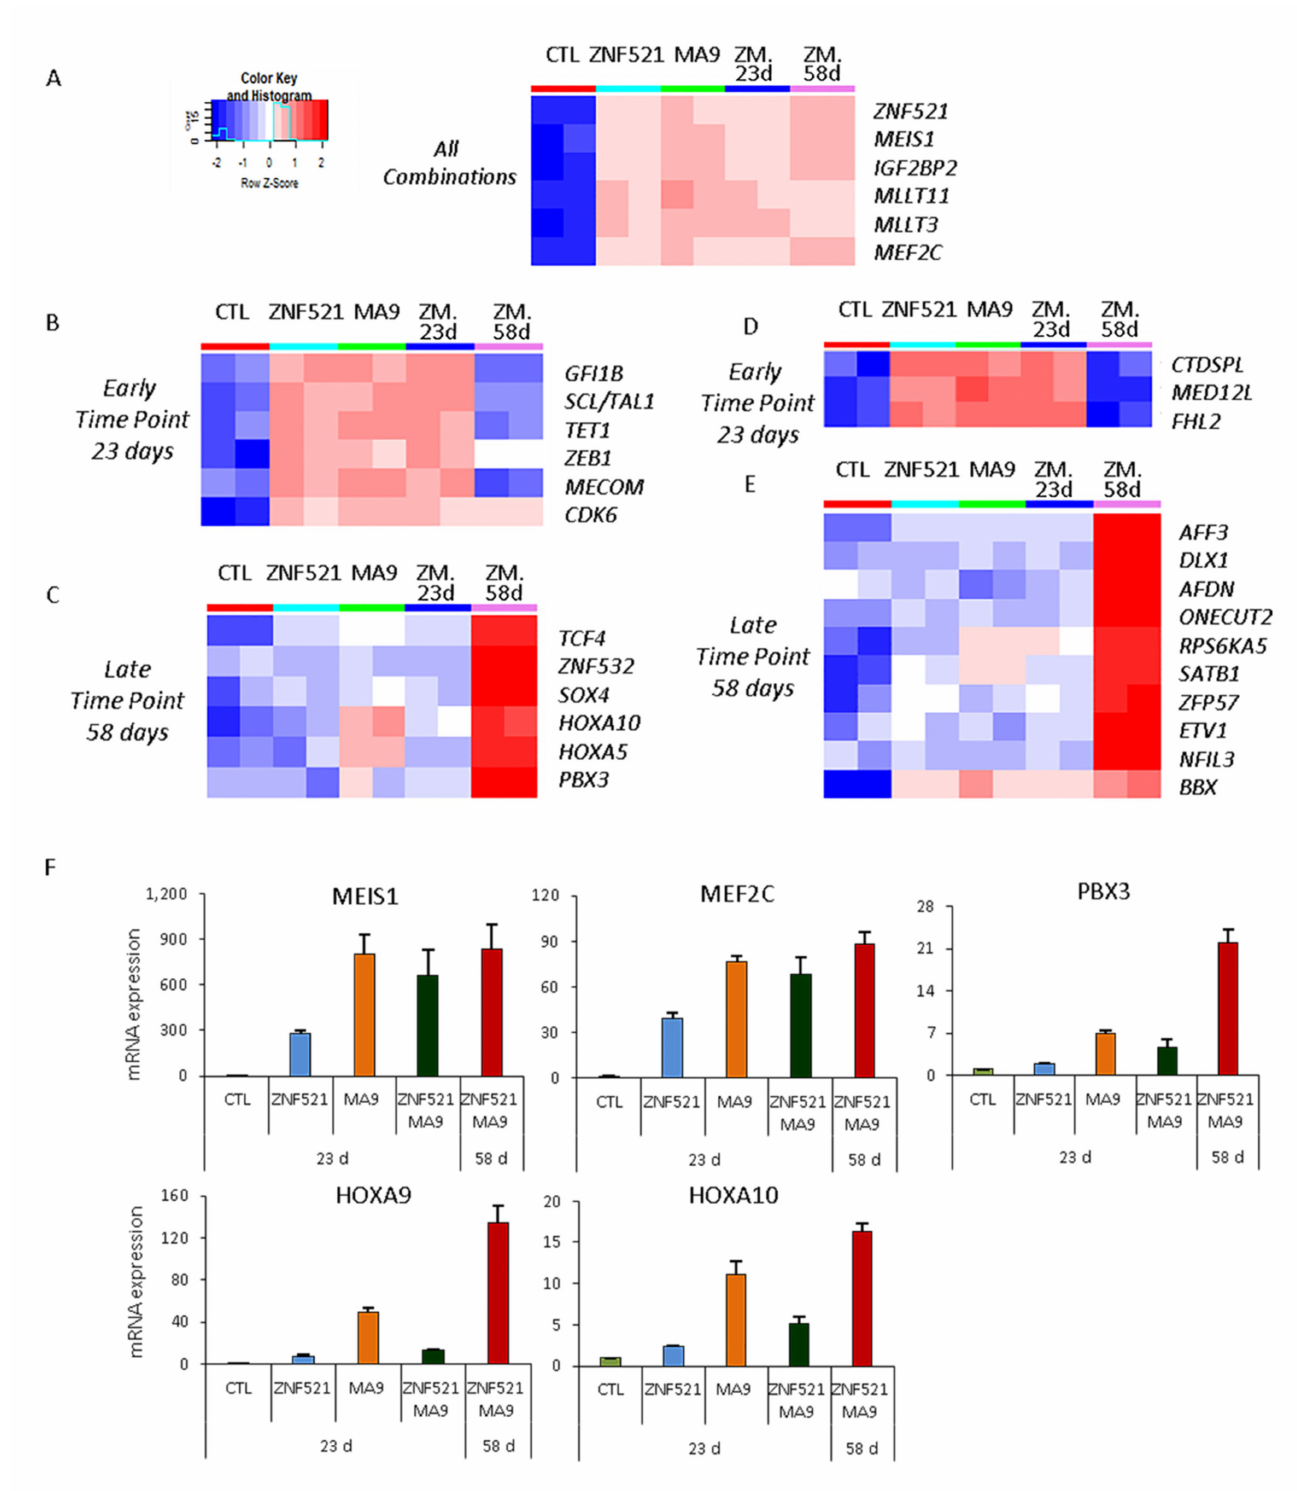
Figure 4. Heatmaps of selected transcripts from differentially expressed transcript lists at FDR < 10% of ZNF521, MA9, and ZNF521-MA9 (ZM) at 23 and 58 days compared to the control condition at 23 days. Known or other target genes that are up-regulated in all comparisons ( A ) at early ( B , D ) or late time points ( C , E ) are depicted. Blue–red color scale was used to set rows with a mean of zero and a standard deviation of one. ( F ) Confirmation of the array by Q-RT-PCR for MEIS1, MEF2C, HOXA10, HOXA9, and